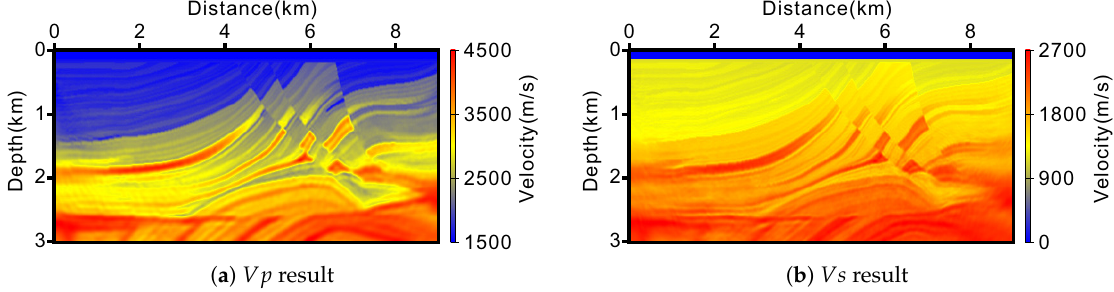
Figure 19. Inverted ( a ) Vp and ( b ) Vs results using AEC-EFWI with 1C pressure data.